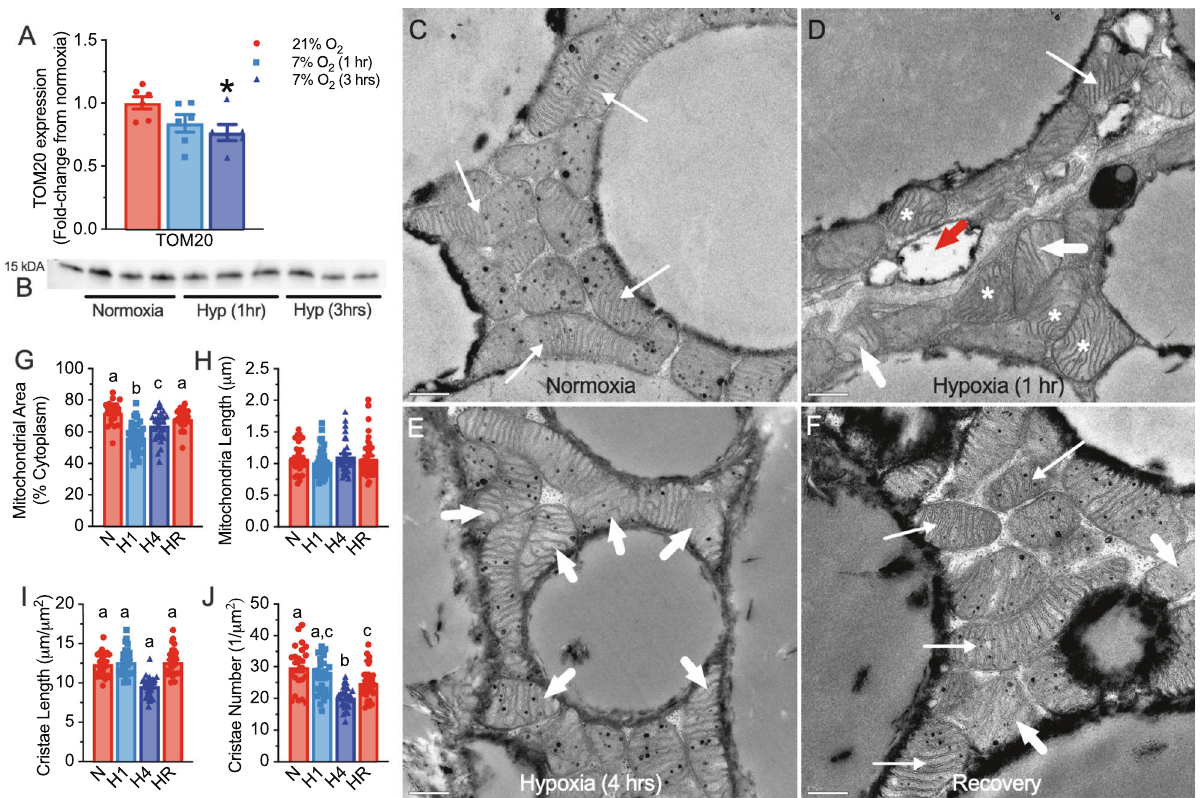
Fig. 5 Mitochondrial and cristae density is reduced in acute hypoxia. A Summary of translocase of outer membrane 20 (TOM20) protein expression in interscapular brown adipose tissue (iBAT) homogenates from naked mole-rats held at 30 °C in normoxia (21% O 2 , red bars; n = 6 biologically independent samples) or after 1 or 3 h of hypoxia (7% O 2 , light and dark blue bars, respectively; n = 6 biologically independent samples). B Western blot image of TOM20 protein bands. C – F Representative electron micrographs of iBAT from naked mole-rats held at 30 °C in normoxia ( C ), 1 h hypoxia ( D ), 4 h